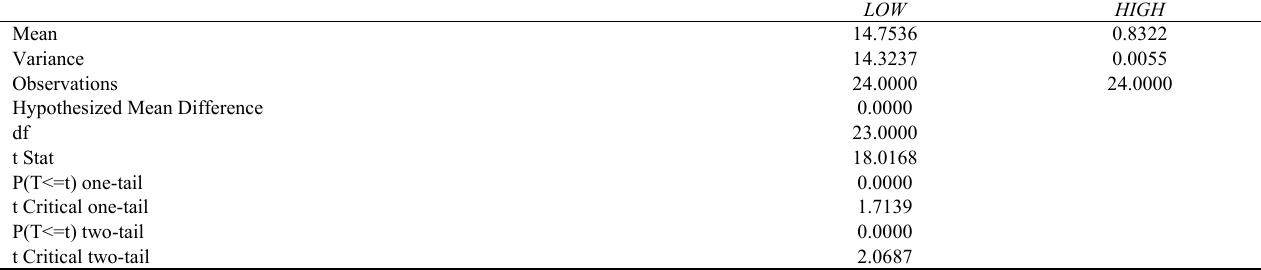
Hypothesis Testing between Bottom rating and High Rating (Sharpe-optimal model) t-Test: Two-Sample Assuming Unequal Variances